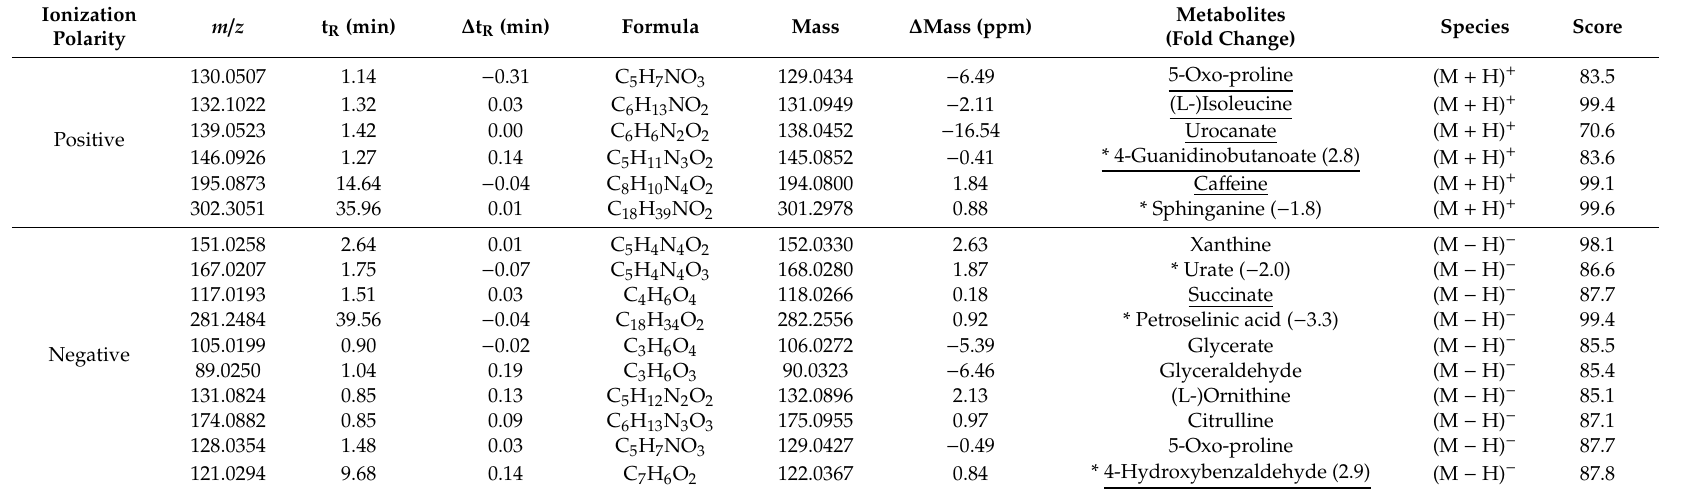
Table 4. Metabolites identified in the hair via LC-QTOF-ESI-MS analysis using in-house